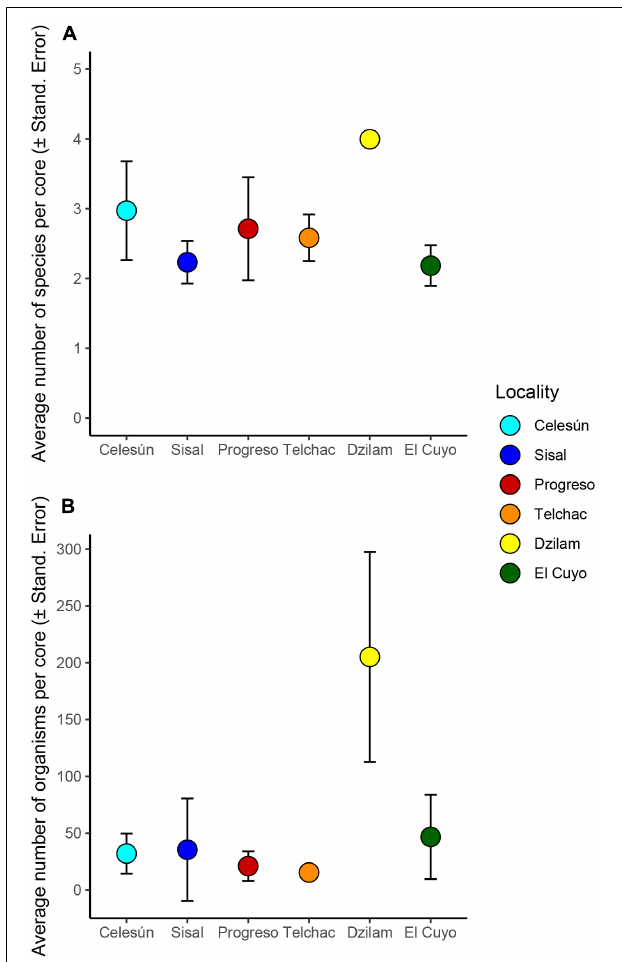
FIGURE 4 | Overall means and standard errors for the density of species (A) and density of organisms (B) per core across the sandy beaches of Yucatán. The standard error was calculated as the standard deviation of the Site averages of each locality. Localities are presented from West to